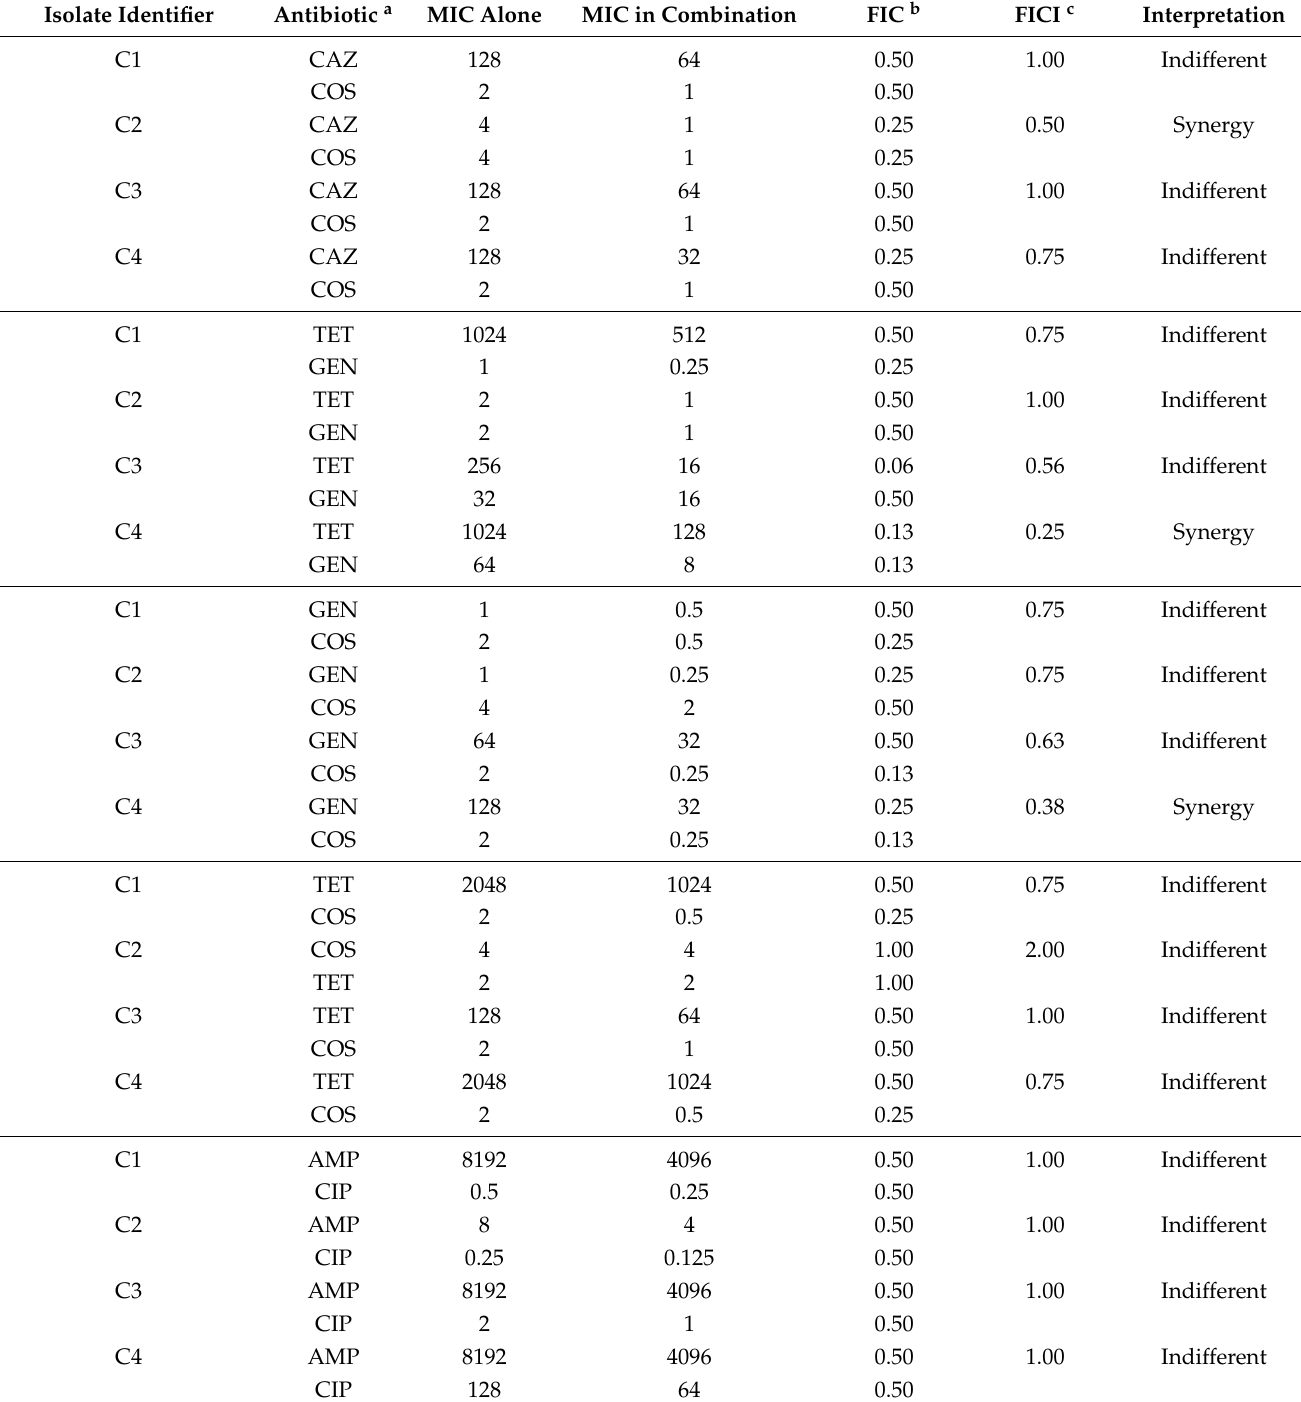
Table 2. The minimum inhibitory concentration (MIC) of various antibiotics alone and the results of the checkerboard assays for multidrug-resistant integron-harbouring Citrobacter